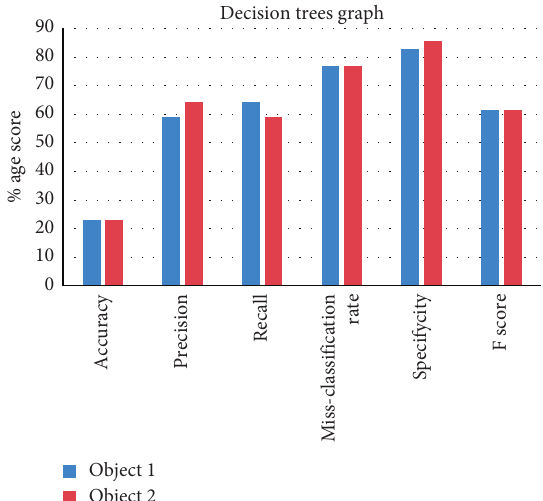
Figure 18: Decision trees based recognition